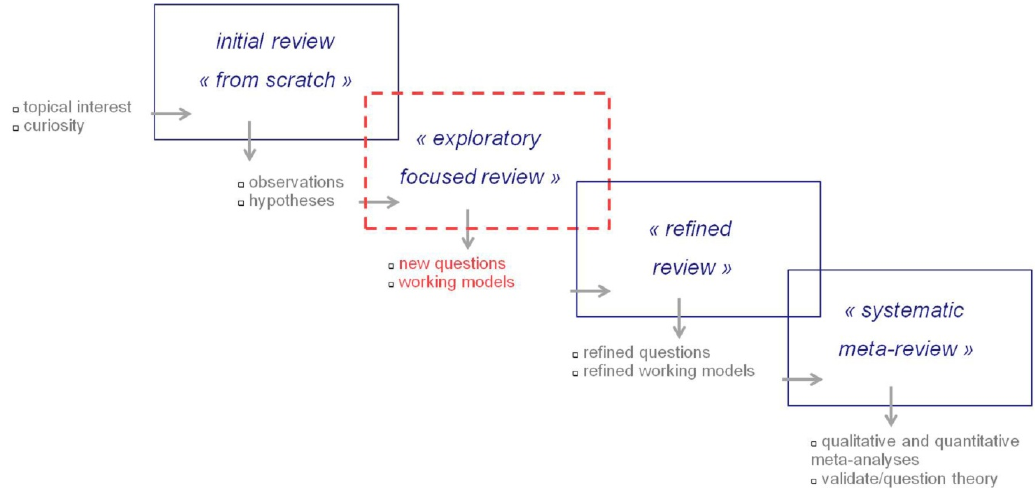
Figure 1. Flowchart of the scientific literature review process, inspired by Liston [24]. A hypothesis-driven, exploratory focused review (cf. the Stanford University standards and recommendations for scientific literature reviews [24]) was performed in this work to produce a temporary working model and inspire further systematic research.